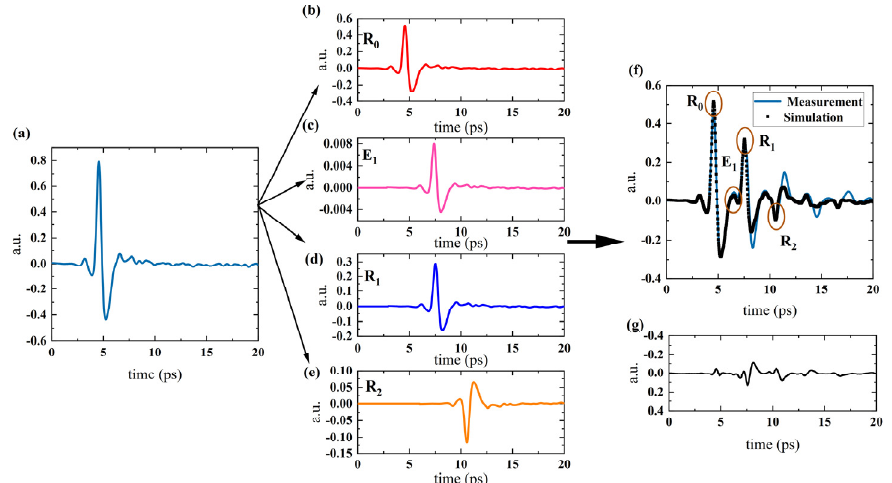
Figure 6. ( a ) The used reference signal obtained by reflective THz experimental platform; ( b ) Simulated signal of R 0 (the surface reflection); ( c ) Simulated signal of E 1 (the TC/TGO interface reflection); ( d ) Simulated signal of R 1 (the first TGO/BC interface reflection); ( e ) Simulated signal of R 2 (the second TGO/BC interface reflection); ( f ) Comparison between the simulated result and the experimental result; ( g ) The difference between the two signals.